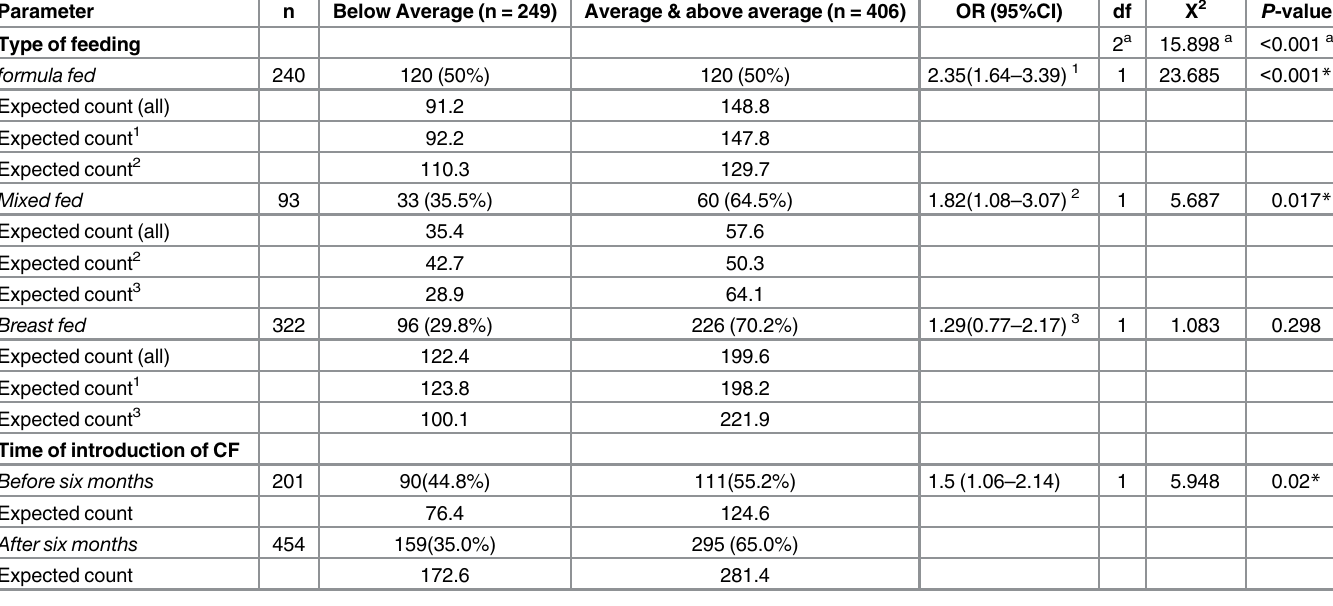
Table 1. Association of infant feeding practices with socio-emotional composite scores categories in a group of 655 Egyptian infants and children aged 6 – 24 months old.